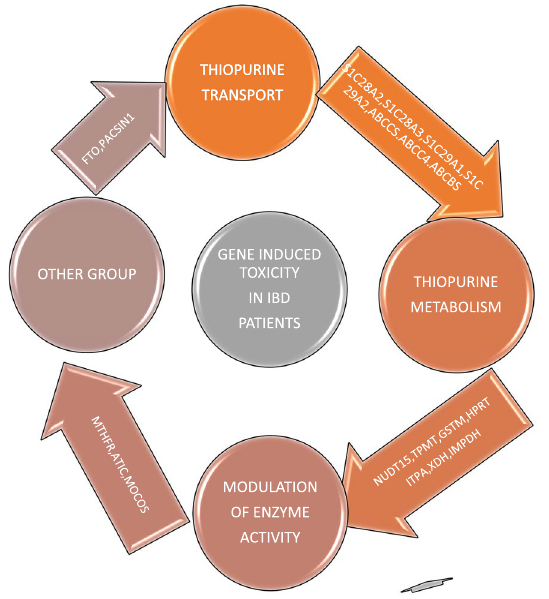
Fig. 2 Potential genes causing cytotoxicity in IBD patient. Explanation of Abbreviations: 28‑member soluble SLC28A2 transporter family 2, The 28‑member soluble SLC28A3 transporter family 3, The soluble SLC29A1 transporter family 29 members